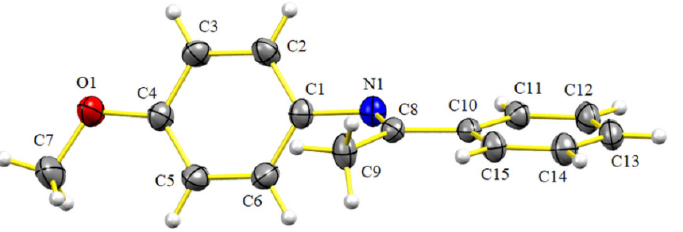
Figure 2. Structure of 5i , as determined by single X-ray diffraction crystallography (ellipsoids at the 30% probability level). 30% probability